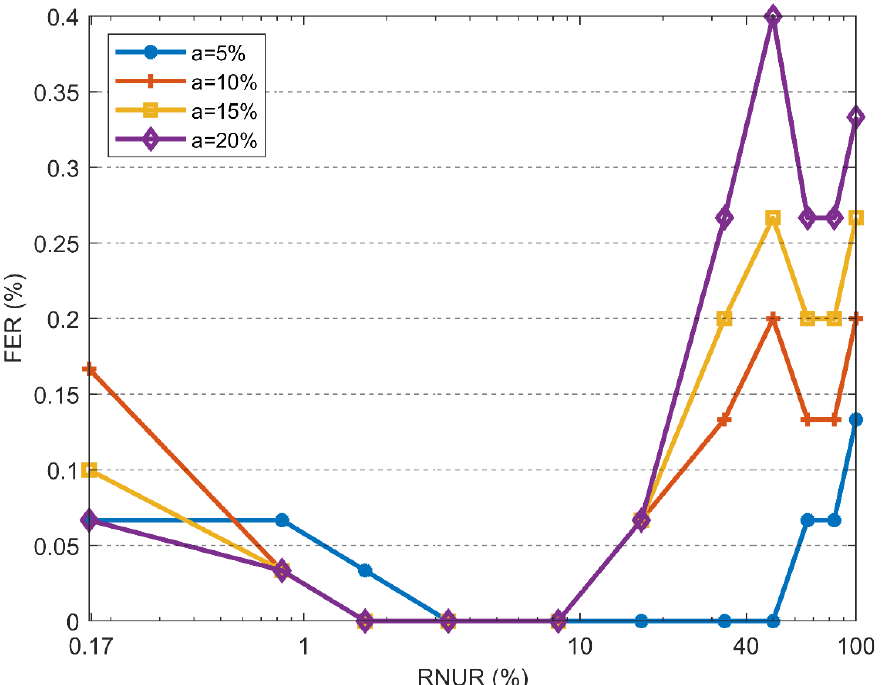
Figure 15. FER of the G3 PLC measured with different values of the RNUR and the modulation index of the RPPM modulated DC ‐ DC converter at 100 kHz switching frequency.